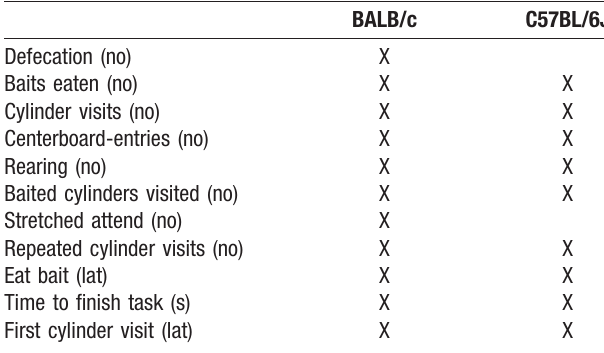
Table 6. Behavioral parameters included in the extracted factors of BALB/c and C57BL/6J mice